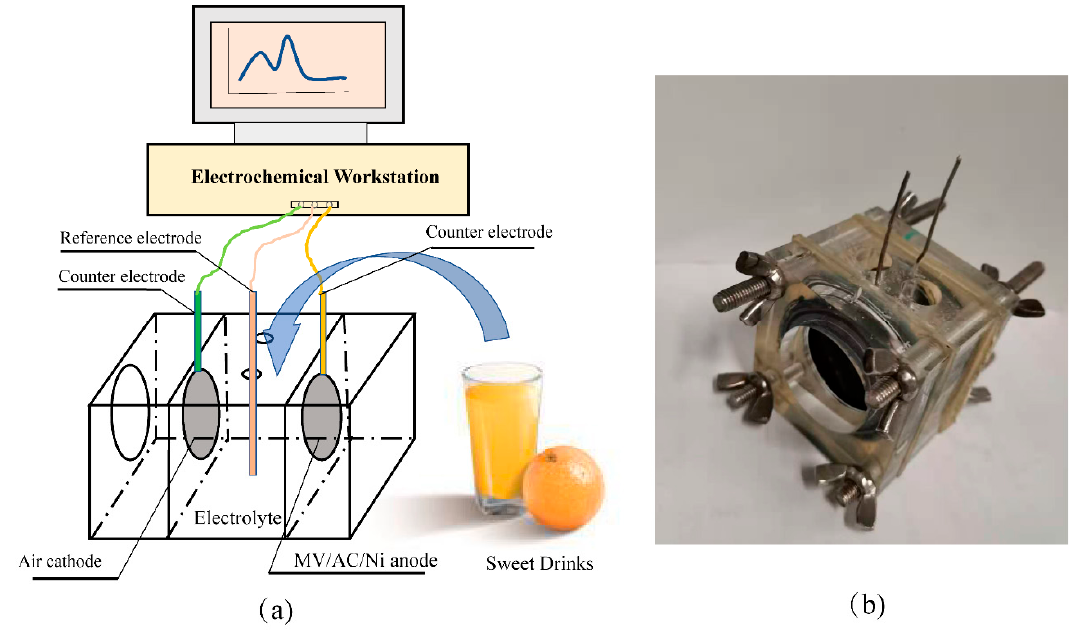
Figure 2. Schematic diagram ( a ) and photograph ( b ) of the AFC used in this study.